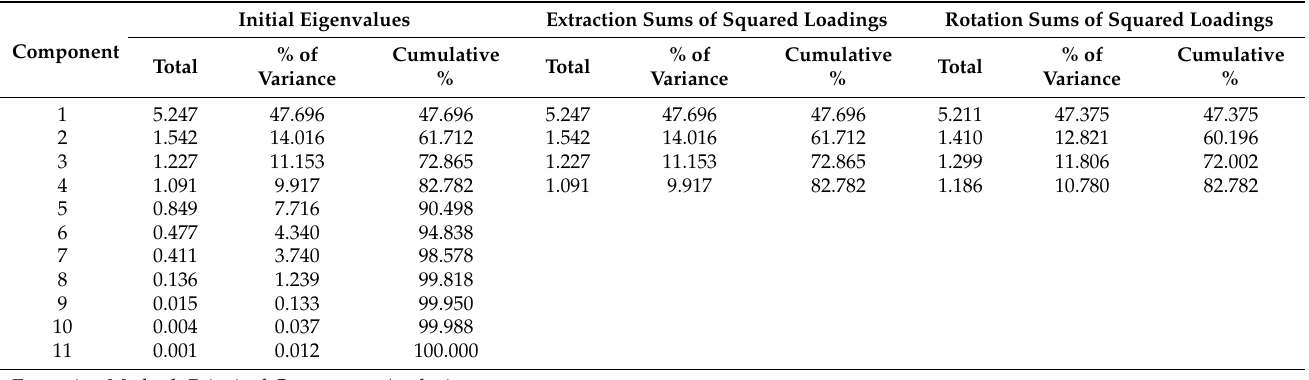
Table 11. Results of principal component analysis—total variance